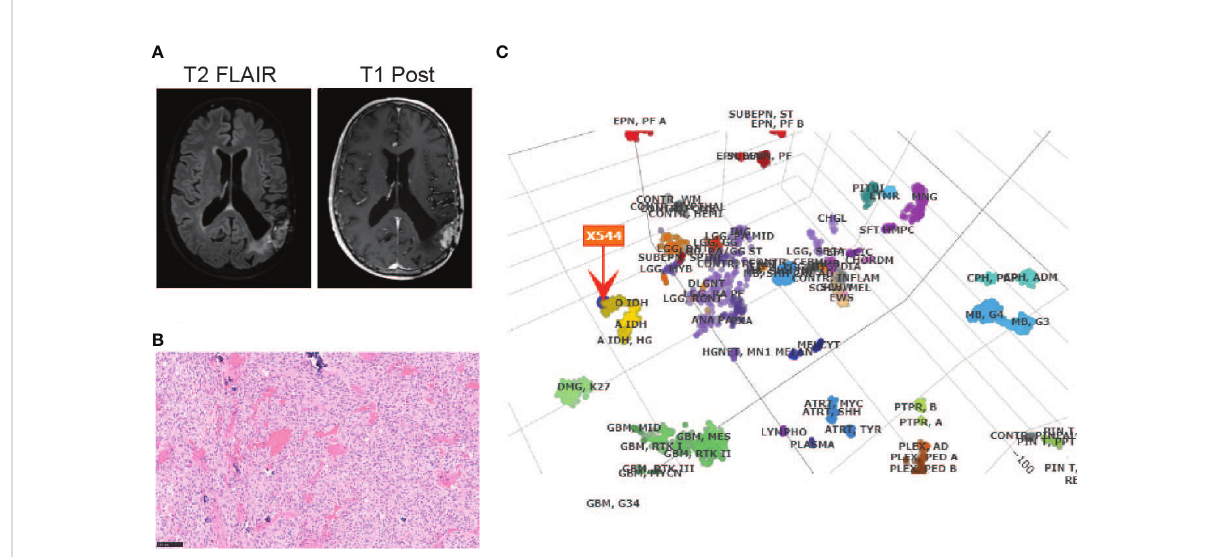
FIGURE 2 Diagnosis of an oligodendroglioma, IDH-mutant and 1p/19q co-deleted, CNS WHO grade 3 by (A) MRI before the most recent tumor resection; (B) H&E staining (20X) and (C) DNA methylation pro fi ling of the tumor sample from the most recent tumor